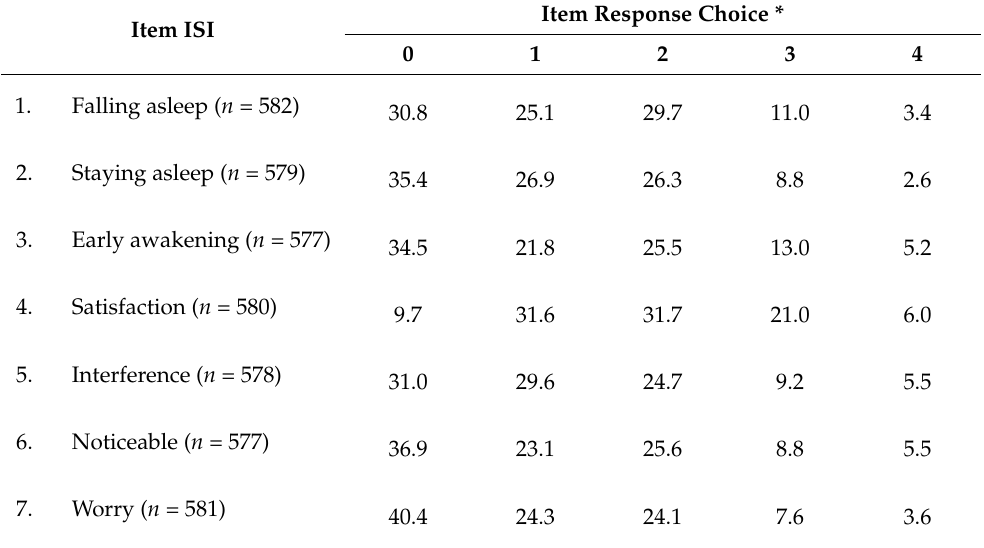
Table 1. Percentage of the sample responded to each item of Insomnia Severity Index (ISI).